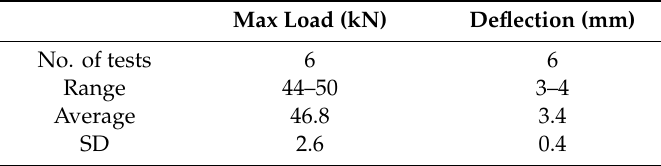
Table 16. Max-load and corresponding deflection average value and standard deviation.